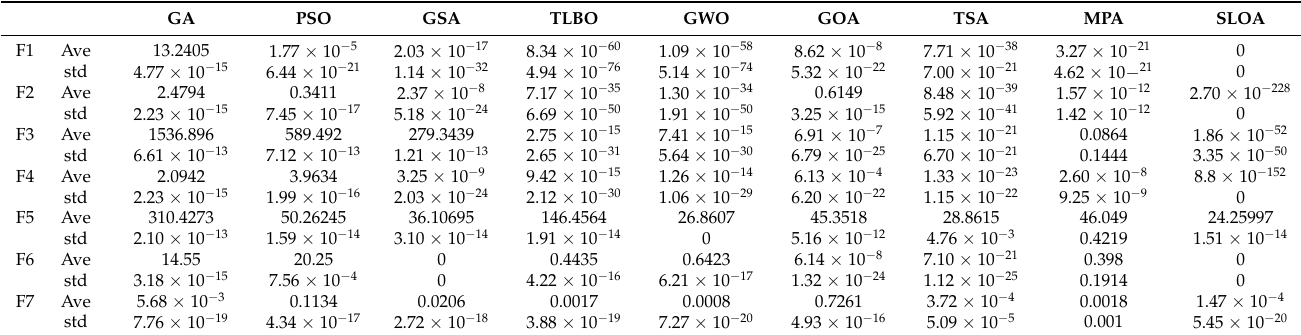
Table 2. Optimization results of SLOA and other algorithms on unimodal test function.